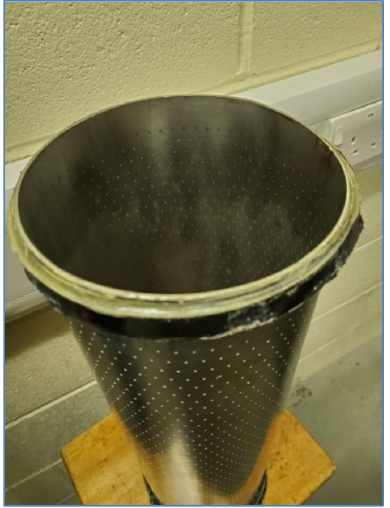
Fig. 1. Illustrates the layout of a single-layer perforated liner pattern utilized at this work.